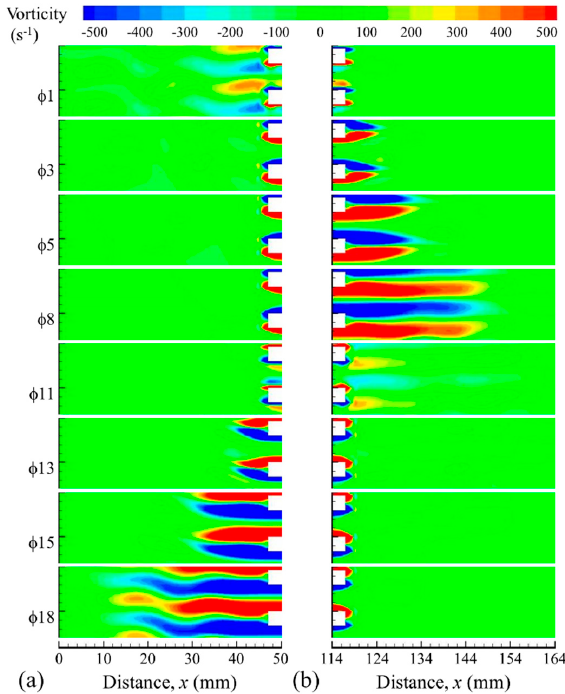
Figure 8. Vorticity contours at the left ( a ) and right ( b ) ends of the heat exchanger assembly calculated using the k- ε model for the drive ratio of 0.83%. Arbitrary distance x is measured along the “viewing area”; vertical axis, y , is omitted for simplicity; the ratio of x : y is